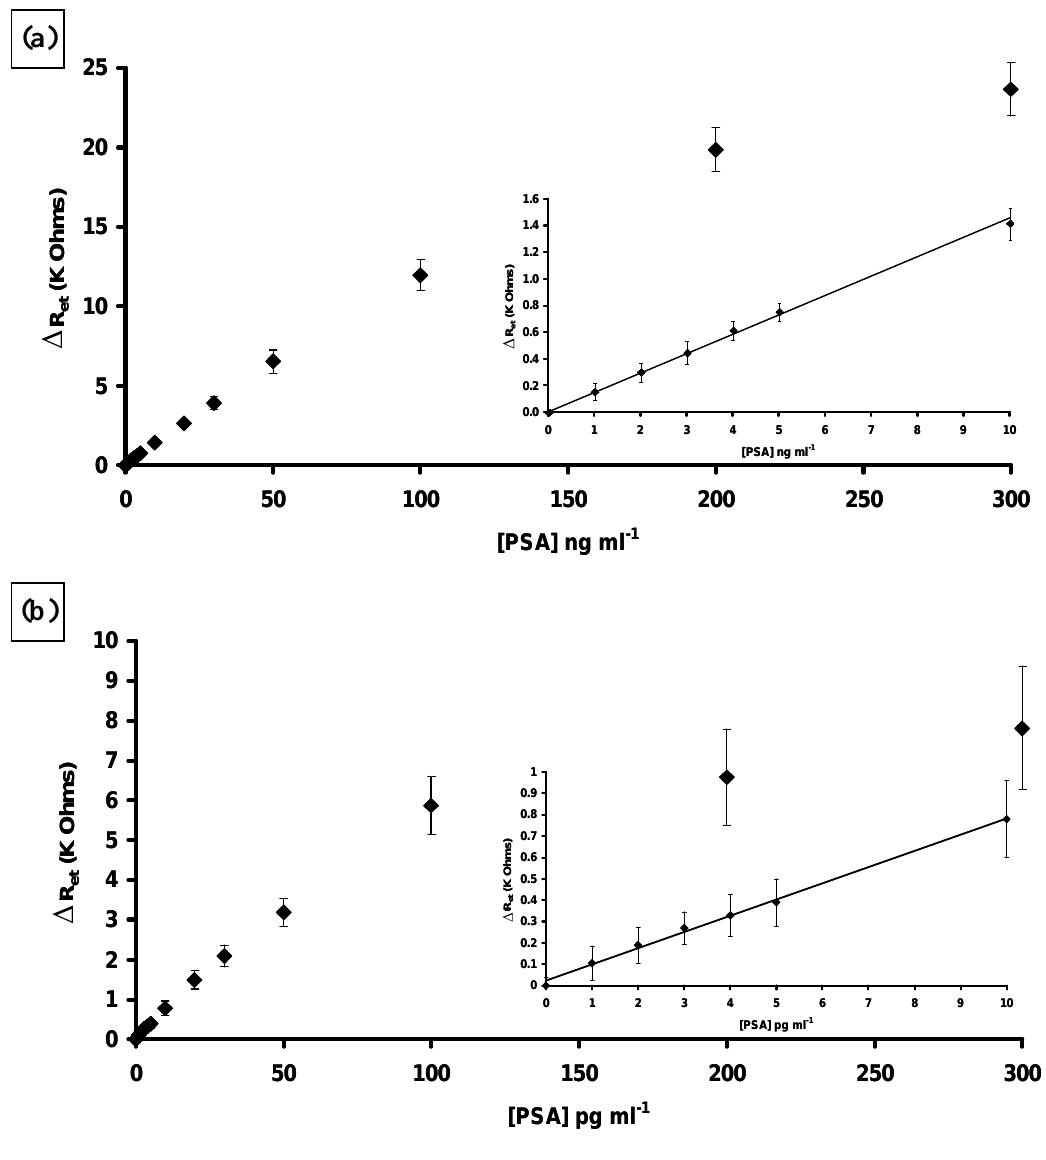
Figure 23. Corrected calibration plots showing changes in electron transfer resistance versus PSA concentration: (a) entrapped APSA 0–300 ng mL –1 PSA, inset 0–10 ng mL